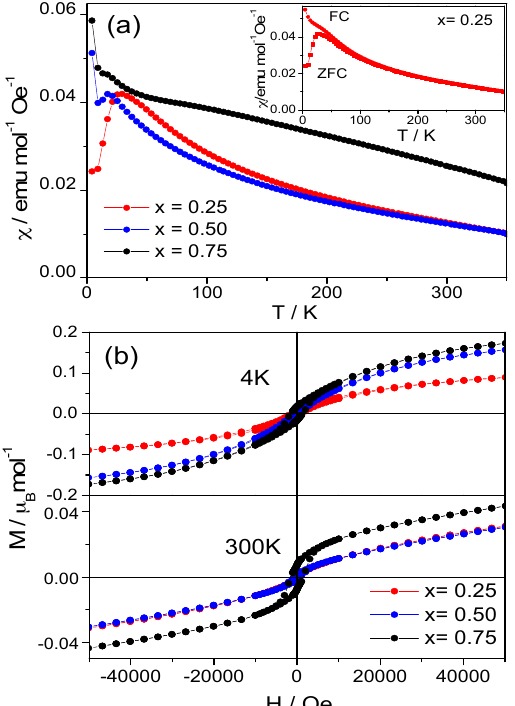
Figure 3. ( a ) Magnetic susceptibility vs. temperature for Sr 1 − x Ba x FeO 2 F; ( b ) magnetization vs. field. ZFC, Zero Field-Cooled.